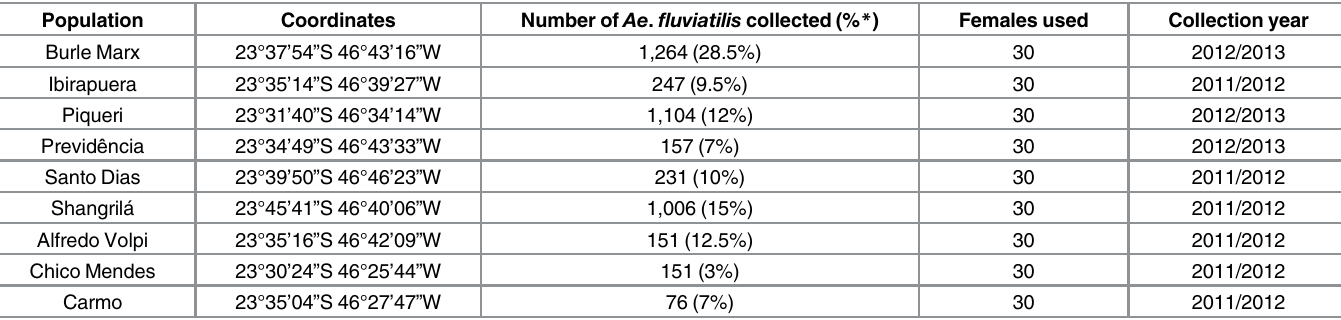
Table 1. Aedes fluviatilis sampling